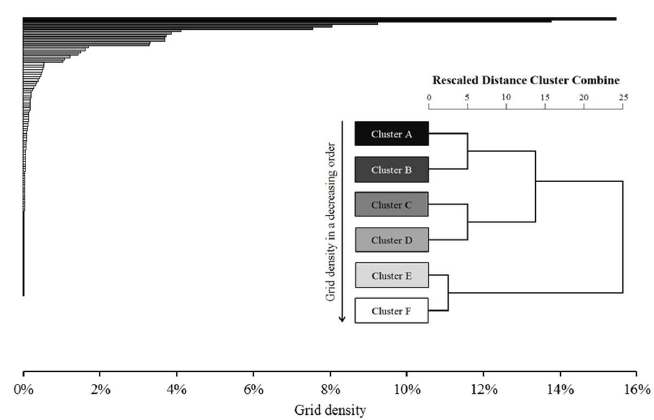
Figure 7. Cell density dendrogram.